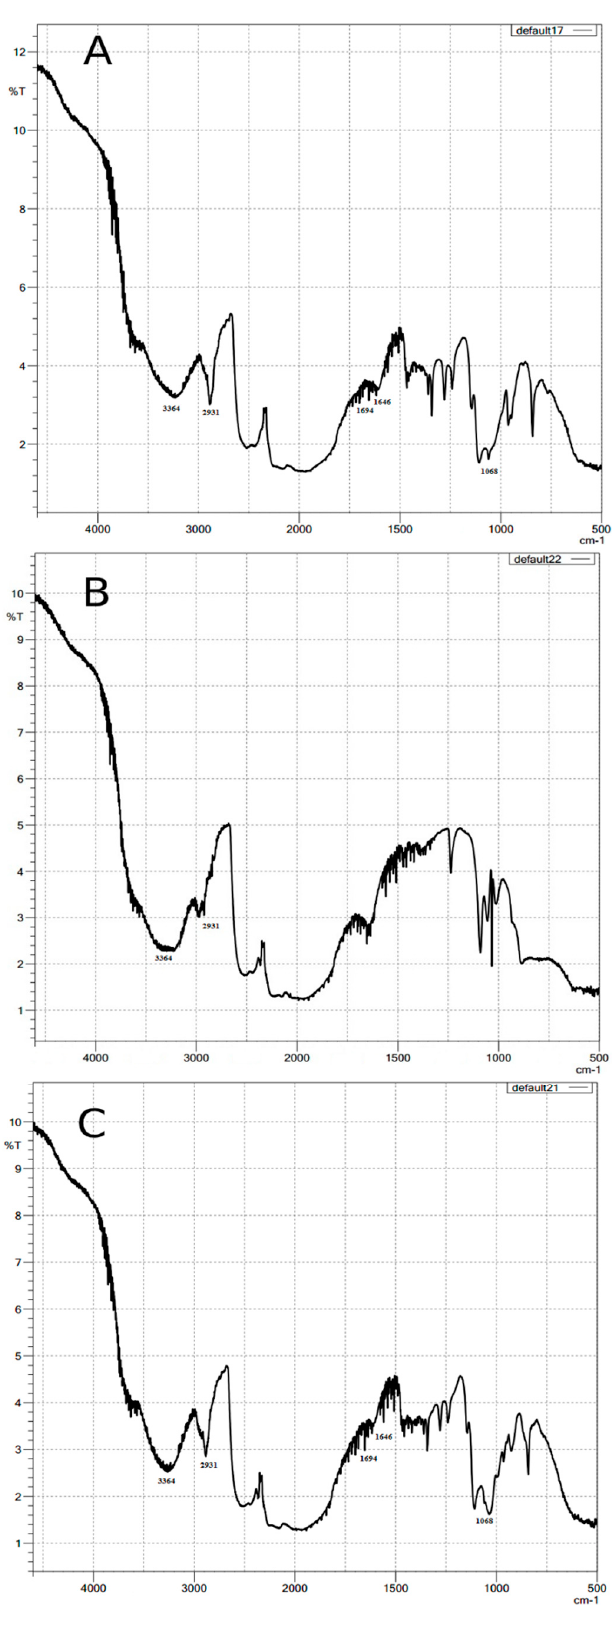
Figure 4. FTIR spectra of a GFD ( A ), CMC powders ( B ) and sublingual film containing FRG (FRG —15 formulation) ( C ).